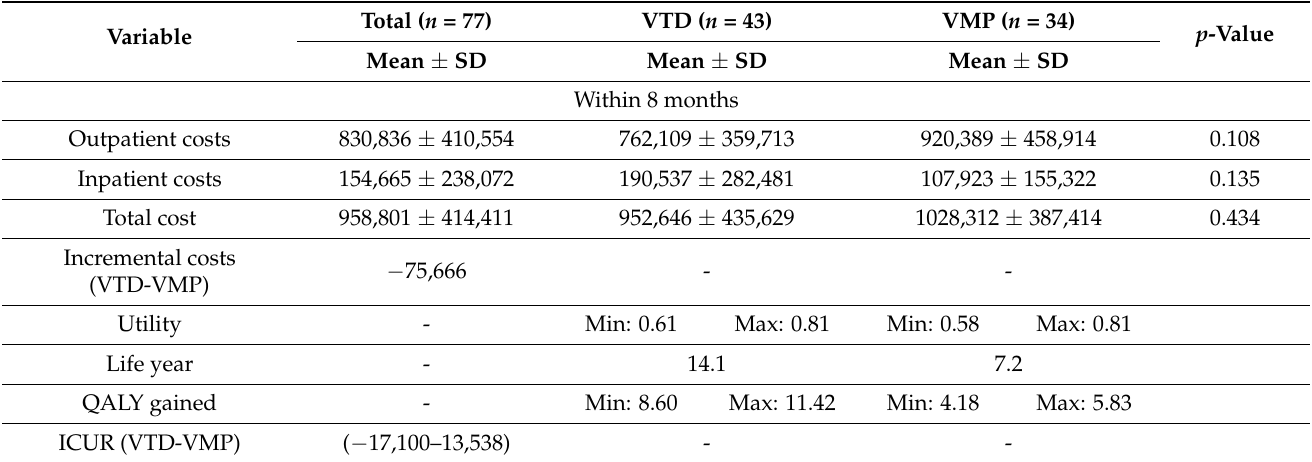
Table 3. Total medical costs, QALY and the ICER (incremental cost-effectiveness ratio) for VTD and VMP